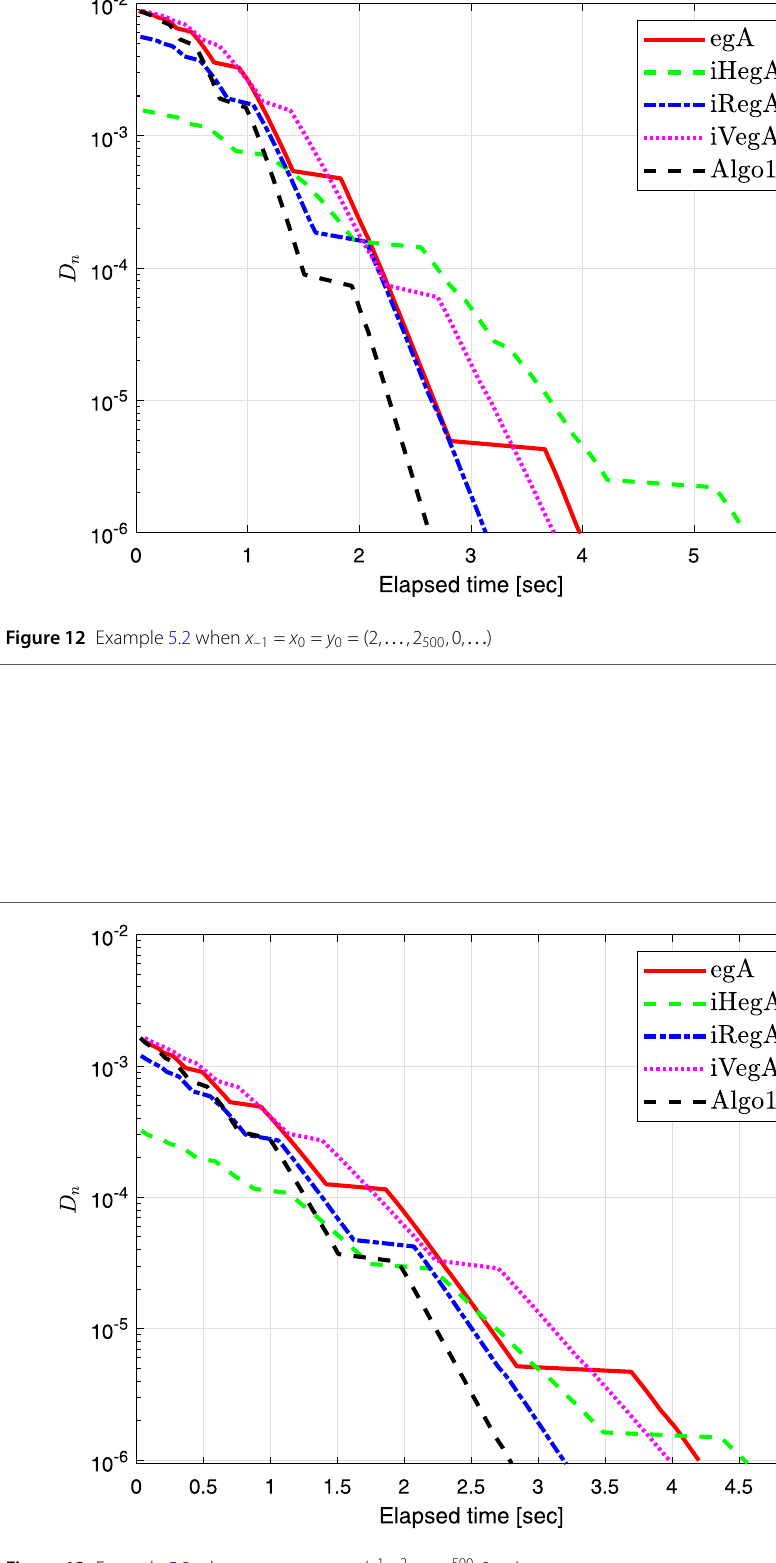
Figure 13 Example 5.2 when x –1 = x 0 = y 0 = ( e 1 , e 2 , ... , e 500 ,0, ...